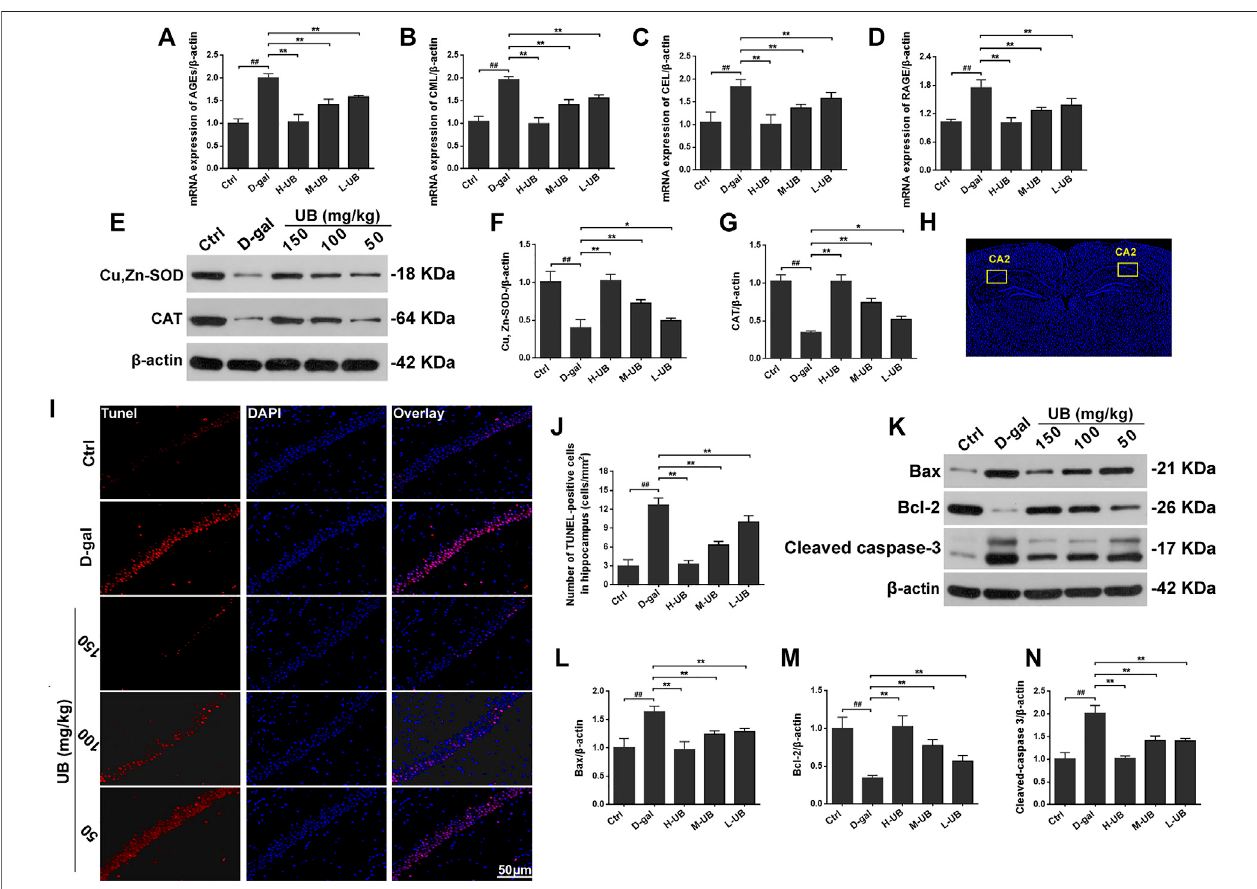
FIGURE 5 | UB supplementation ameliorated the mRNA expression ofAGEs (A) , CML (B) , CEL (C) and RAGE (D) in D-gal-induced aging mice ( n (cid:1) 6 per group). (E) UB enhancedtheactivityofCu,Zn-SODandCATinhippocampaltissue.Quanti fi cationanalysisofCu,Zn-SOD (F) andCAT (G) .Datawerenormalizedto β -actinproteinexpression ( n (cid:1) 6 per group). (H) Representative tunel staining of the hippocampal CA2 region. (I) TUNEL assays were performed to evaluate apoptosis in the hippocampus in vivo. (J) The relativeproportion ofTUNEL-positivecellsin thehippocampusofagingmice( n (cid:1) 6per group). (K) Proteinexpression ofBax, Bcl-2and cleaved caspase-3in thebrainsof agingmicewasdetectedbywesternblotting.Quanti fi cationanalysisofBax (L) ,Bcl-2 (M) andcleavedcaspase-3 (N) .Datawerenormalizedto β -actinproteinexpression( n (cid:1) 6per group). All results are described as means ± SD. # p < 0.05 and ## p < 0.01 vs the control group; * p < 0.05 and ** p < 0.01 vs the D-gal-induced aging group.